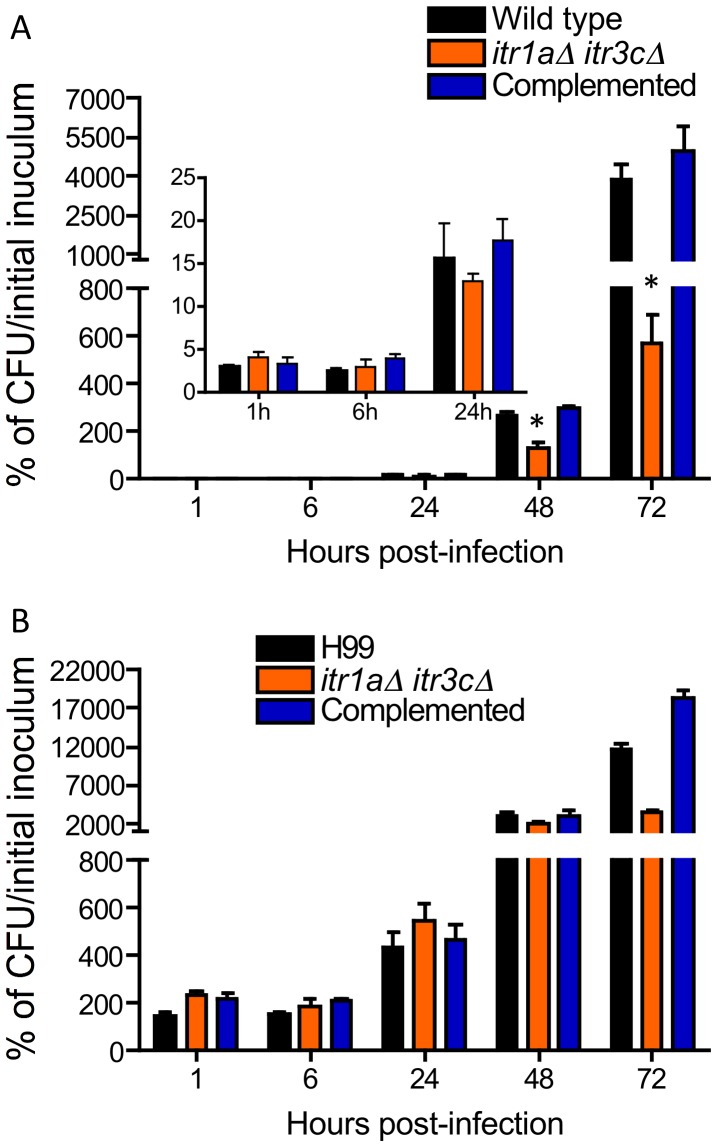

ITRs are required for traversal crossing of the BBB in a mouse intravenous model.CFUs were recovered from either the brain (A) and the lung (B) of mice injected with H99, the itr1aΔ itr3cΔ double mutant or its complemented strain at indicated times post-inoculation. CFU values are expressed as percentages of the initial inoculum. Error bars indicate standard deviations. “*” indicates statistical significance (P<0.001).